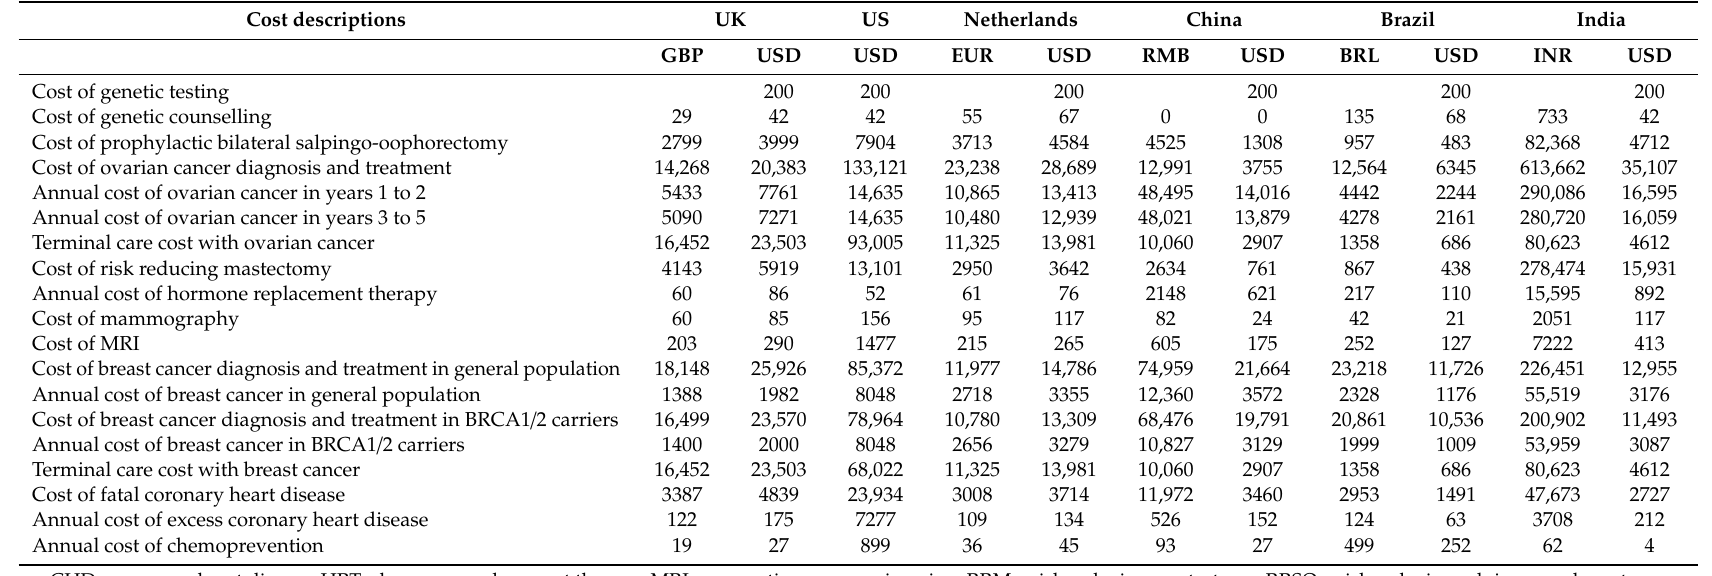
Table A2. Medical costs in 2016 values (USA dollars converted by